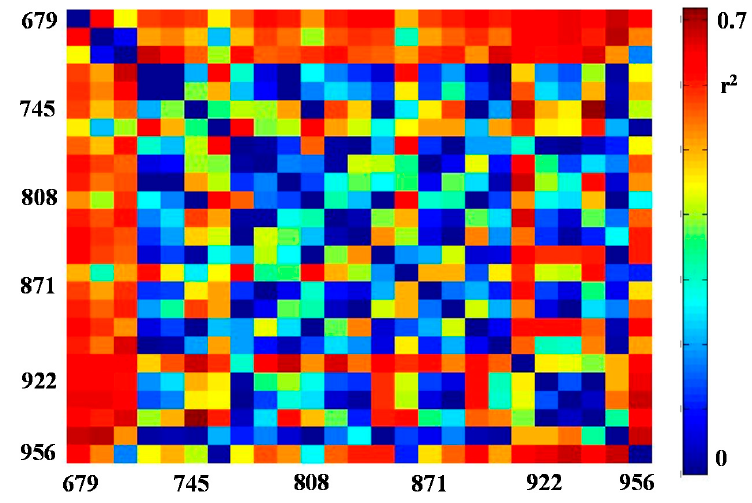
Figure 3. Contour maps of the coefficient of determination (r 2 ) between flower number and normalized difference spectral index (NDSI) using random spectral band λ 1 and λ 2 within the spectral region of 600 − 1000 nm.